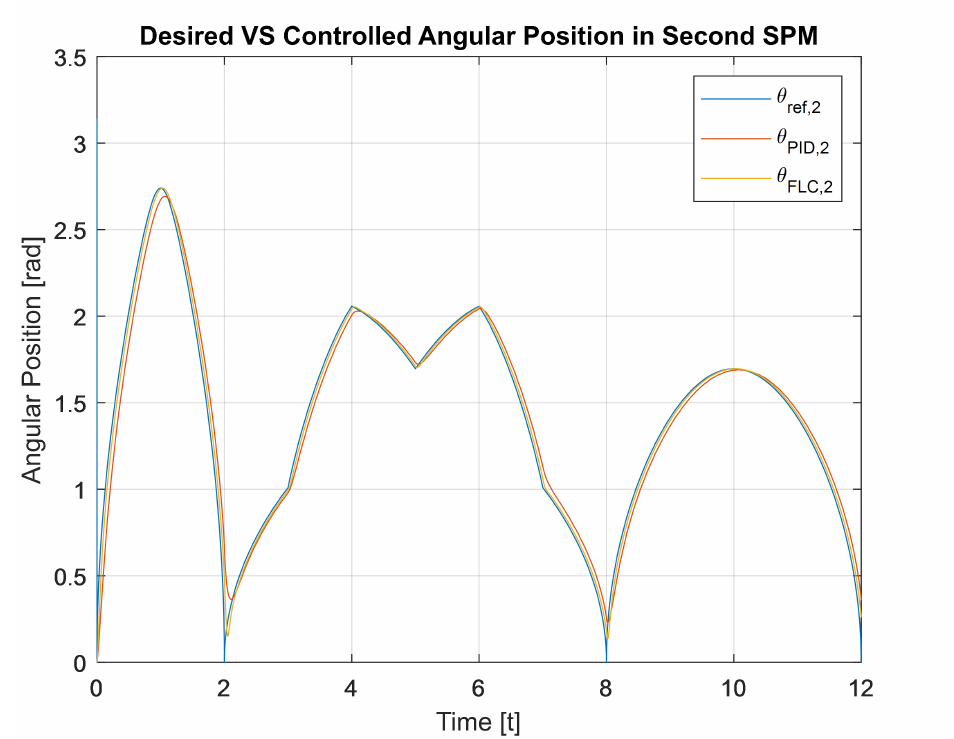
Figure 7. Second joint trajectory tracking